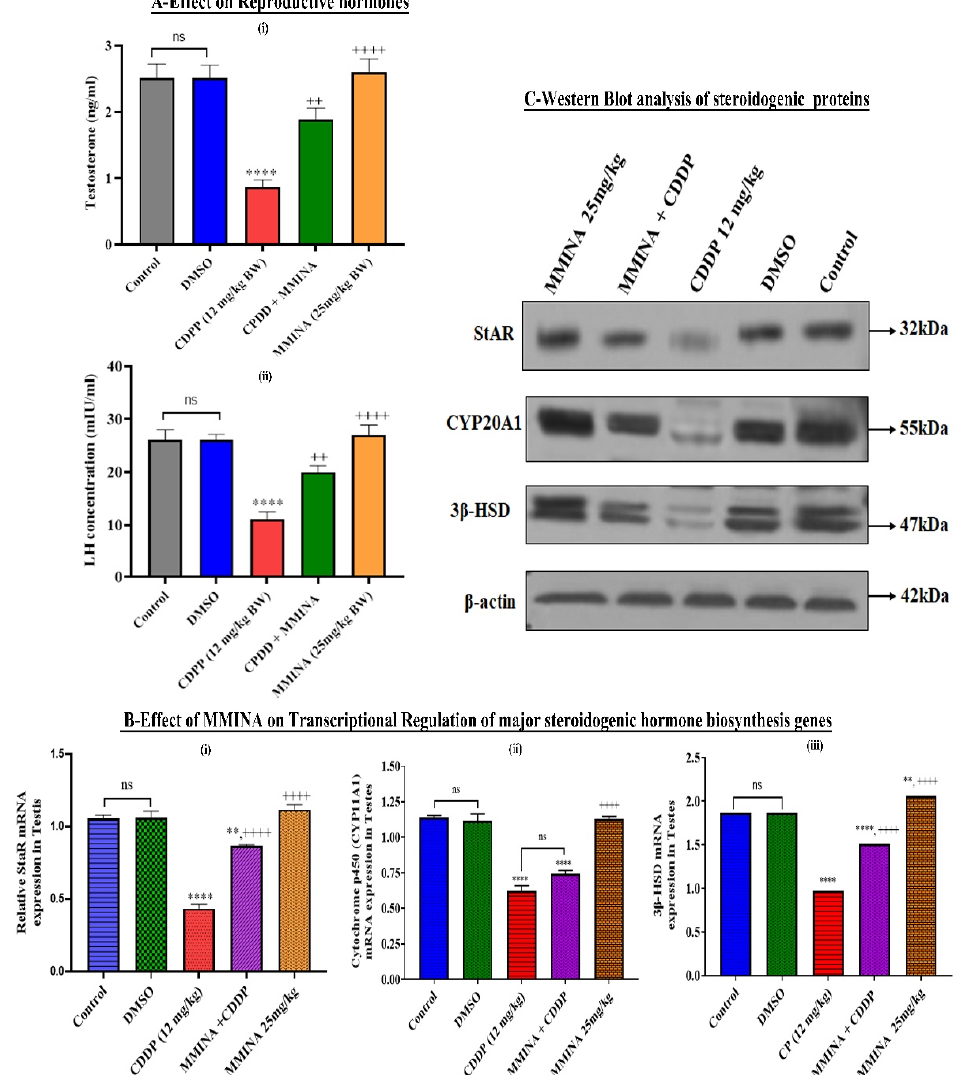
Figure 2. MMINA upregulated protein expression levels of the key testosterone synthesis factors and related hormones in rat testes. ( A ) Effect on reproductive hormones; (i): testosterone, (ii): LH. ( B ) Effect of MMINA on transcriptional regulation of the steroidogenic hormone biosynthesis gene. rtPCR analysis of StAR (i), CYP11A1 (ii), and 3β-HSD (iii) mRNA expression. ( C )-StAR, CYP11A1, and 3β-HSD protein content were determined by Western blot analysis. Values were expressed as mean ± standard deviation ( n = 7). **, **** p < 0.05 and p < 0.0001 versus control, respectively, and ++ , ++++ p < 0.05 and p < 0.0001 versus CDDP. Data were analyzed by one-way ANOVA followed by Tukey’s multiple comparison tests using graph pad prism version 9. STAR: steroidogenic acute reg- ulatory protein, CYP11A1: P450 side-chain cleavage enzyme, HSD17B: 17β-hydroxysteroid dehy- drogenase. Uncropped blots are presented in Supplementary File S3.